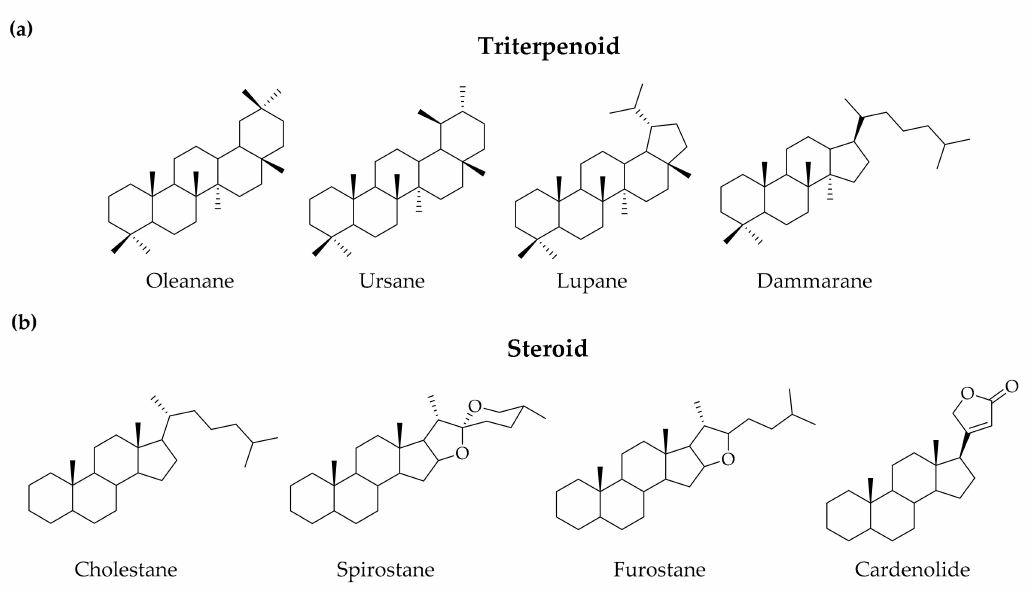
Figure 1. Representative sapogenin structure of ( a ) triterpenoid saponins and ( b ) steroid